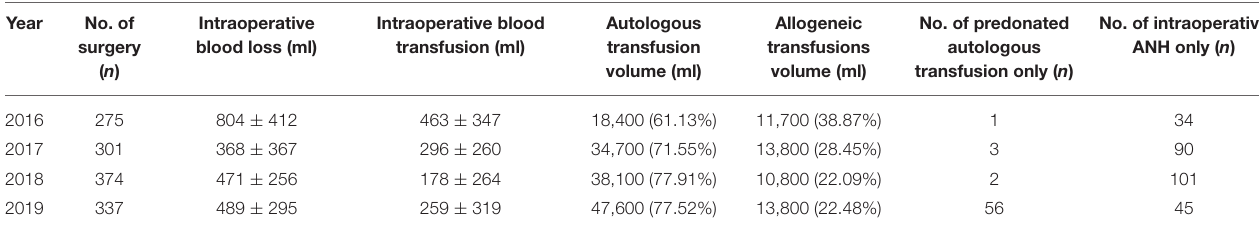
TABLE 2 | Intraoperative blood loss and transfusion volumes in liposuction surgery. Year No. of